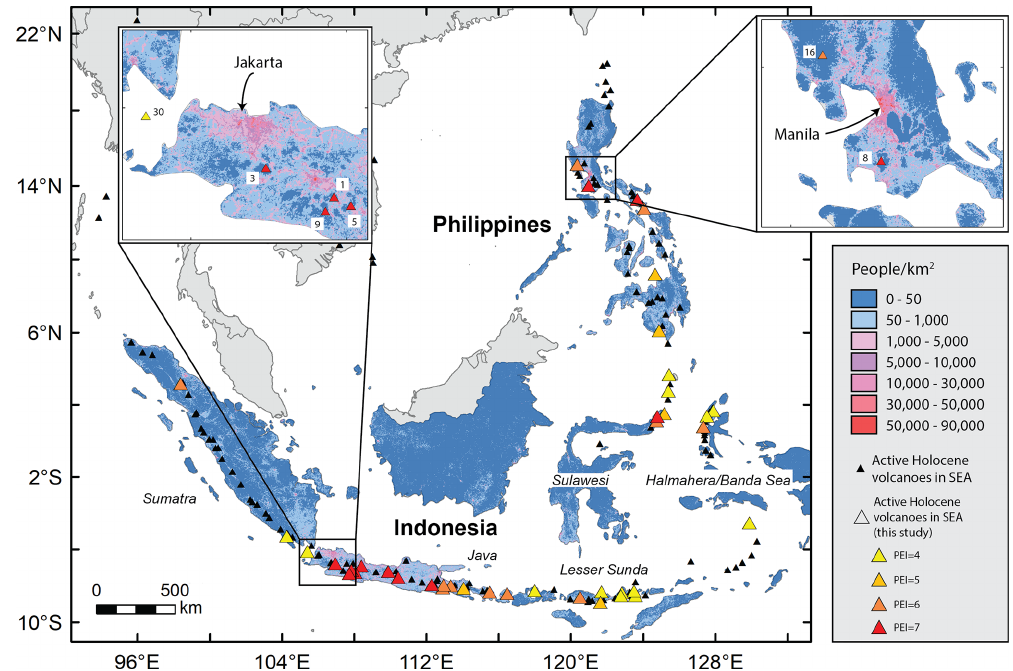
Figure 1. Active Holocene volcanoes of Southeast Asia (black triangles, as defined in Global Volcanism Program, 2013) with the 40 vol- canoes considered for analysis in this study highlighted as larger triangles, with their colour dictated by their PEI. Basemap is ambient population per 1km 2 (LandScan 2018; Rose et al., 2019). Numbers relate to the volcano name and PEI in Table